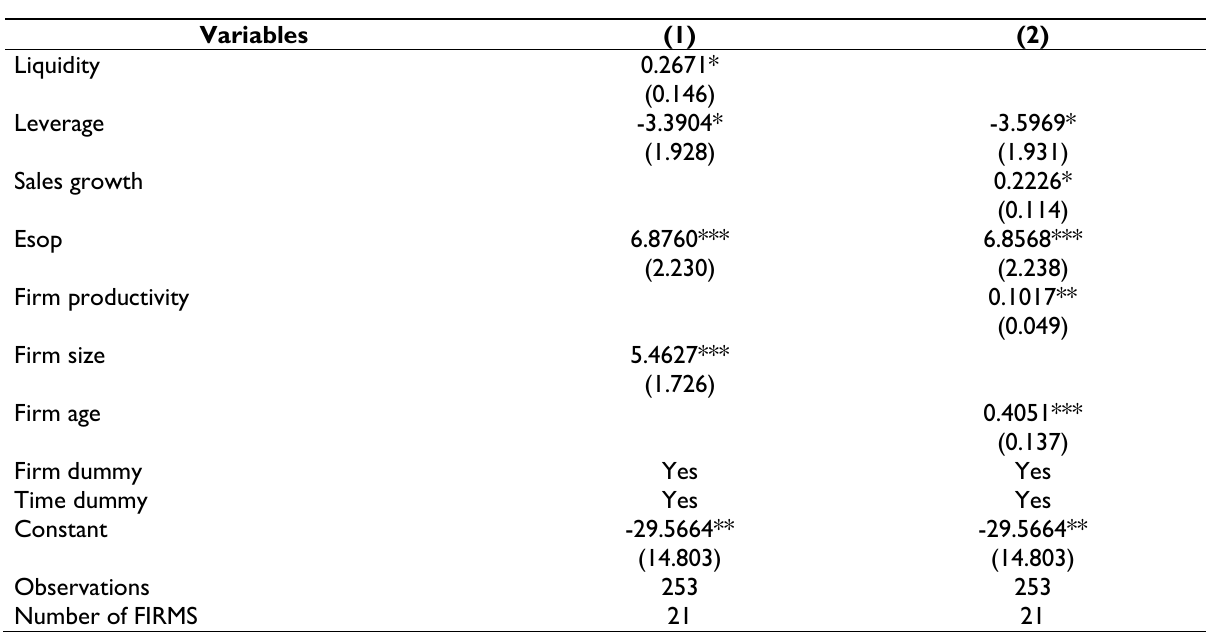
Table 8 POLS Model on ESOP and